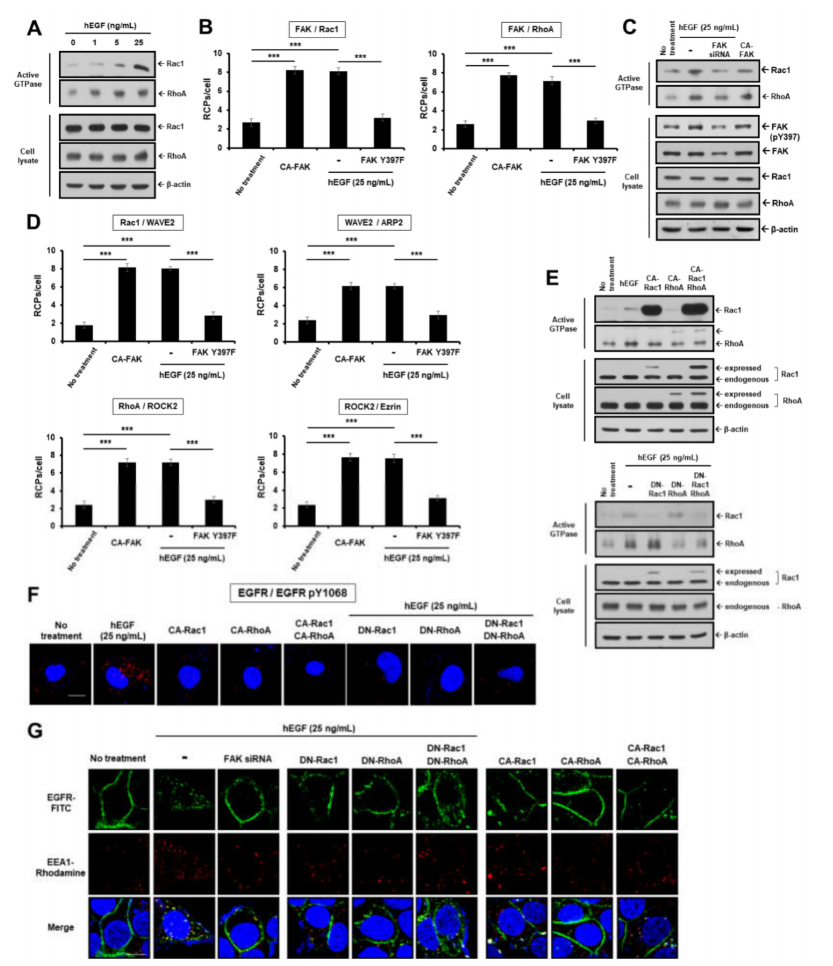
Figure 2. FAK functions as a critical mediator in EGF-induced activation of Rac1 and RhoA GTPases during EGFR signaling. ( A , C ) MCF-7 cells stimulated by binding of ligand to its receptor were analyzed for activation of small GTPases. Activated GTP-bound Rac1 or RhoA in the cell lysates were determined by immunoblotting with anti-Rac1 or anti-RhoA antibodies. β -actin was used as a loading control. ( B , D ) MDA-MB-231 cells were transfected with CA-FAK or FAK Y397F plasmids and incubated in the presence or absence of 25 ng / mL EGF at 37 ◦ C, 5% CO 2 for 15 min. The interactions between the pairs of molecules indicated were assessed by in situ PLA. *** p < 0.001. ( E ) Activation of small GTPases in MCF-7 cells was determined by immunoblotting. ( F ) EGFR dimerization in MDA-MB-231 cells was assessed by in situ PLA and the experiments were duplicated. ( G ) EGFR endocytosis in MCF-7 cells was determined by IFA as described above. Original magnification of representative images, 600 × . Scale bars = 10 µ